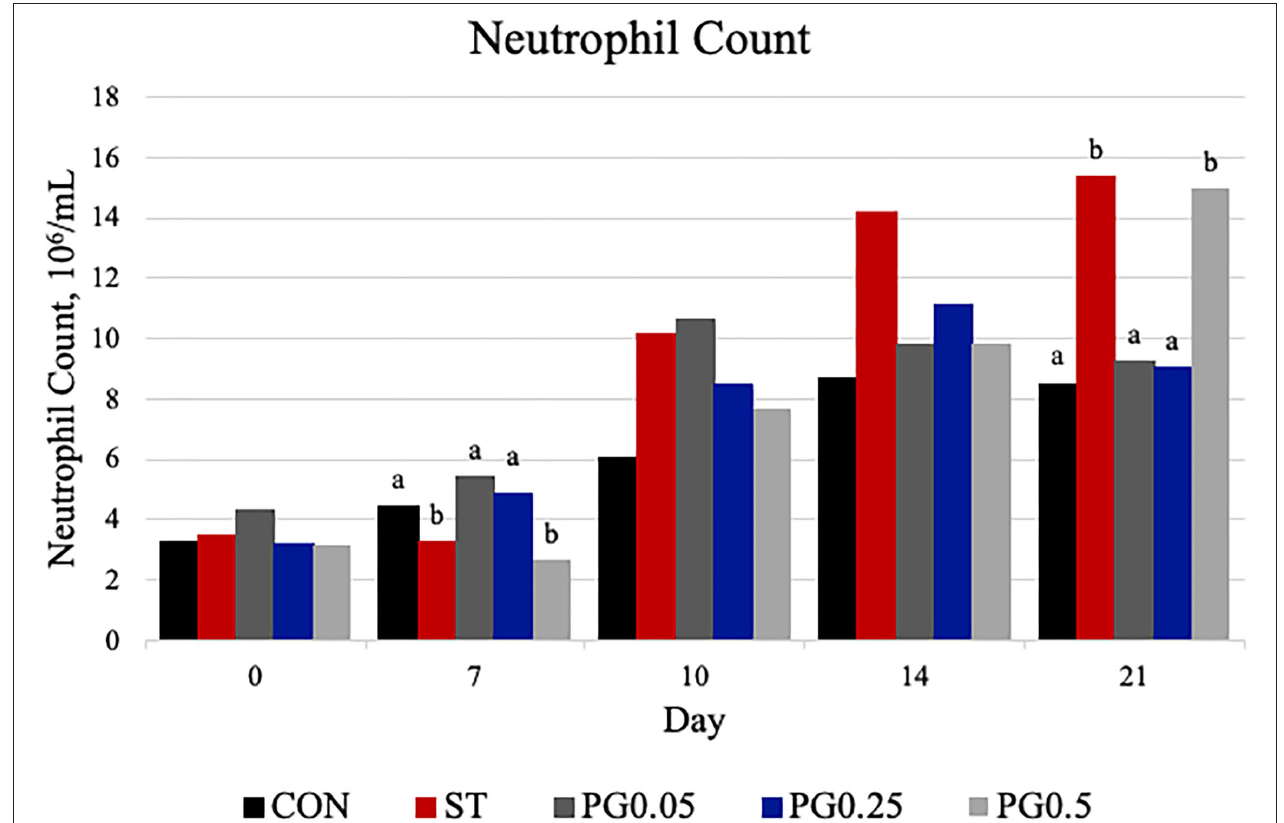
FIGURE 8 | Neutrophil count was measured on days 0, 7, 10, 14, and 21. There was a treatment × time interaction ( P = 0.0026). There were treatment differences on day 7 ( P = 0.0023) and day 21 ( P = 0.0116). On day 7, treatments PG0.05 and PG0.25 were decreased when compared to ST and PG0.5 ( P ≤ 0.0078); CON was also increased when compared to PG0.5 ( P = 0.0177). On day 21, treatments PG0.05, PG0.25, and CON were decreased when compared to the ST and PG0.5 treatments ( P ≤ 0.0313). The largest SEM is reported per time point as 10 6 /ml and include 1.066, 0.7756, 2.243, 2.278, and 2.692 for days 0, 7, 10, 14 and 21, respectively. Bars with different superscripts are statistically different ( P <